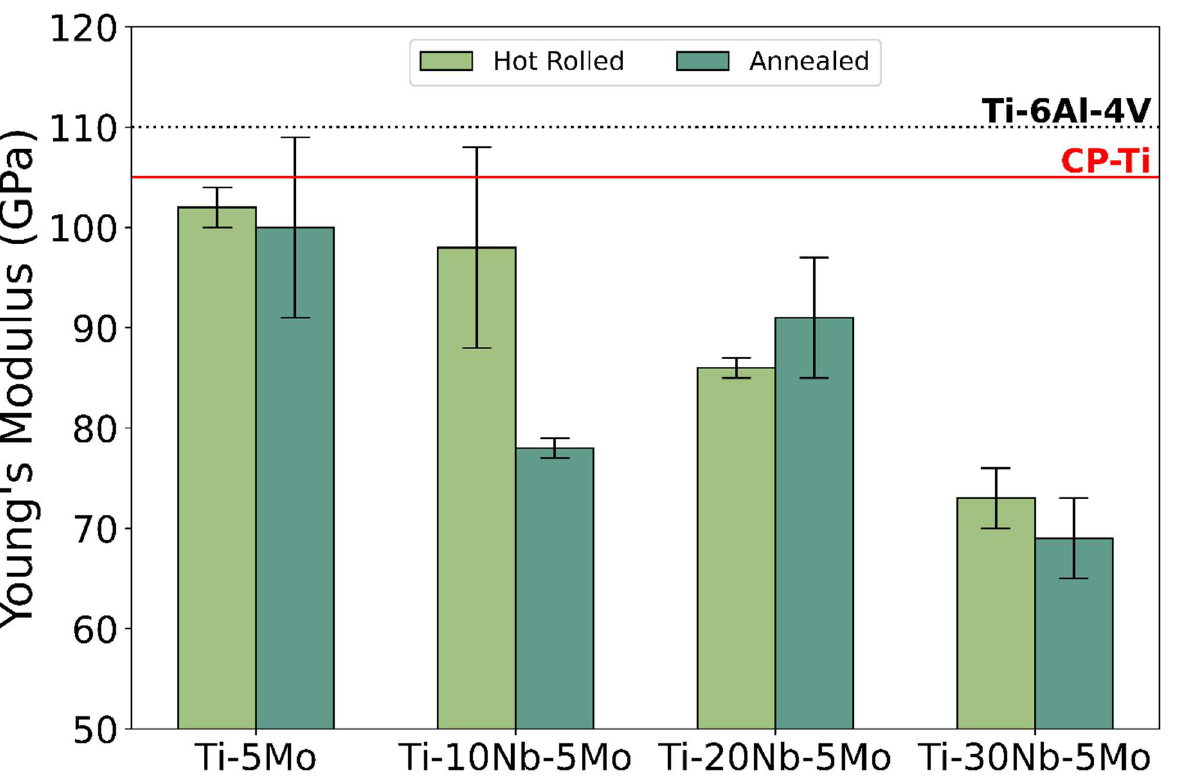
Figure 8. Young’s Modulus of the Ti-xNb-5Mo samples as a function of thermomechanical processing.